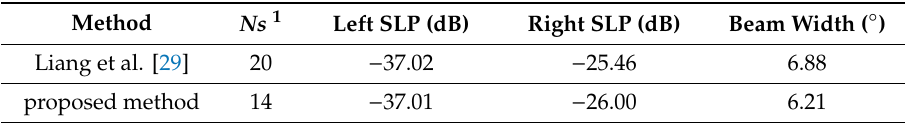
Table 4. Comparisons of asymmetric sidelobe BP synthesis results among the proposed method and the existing